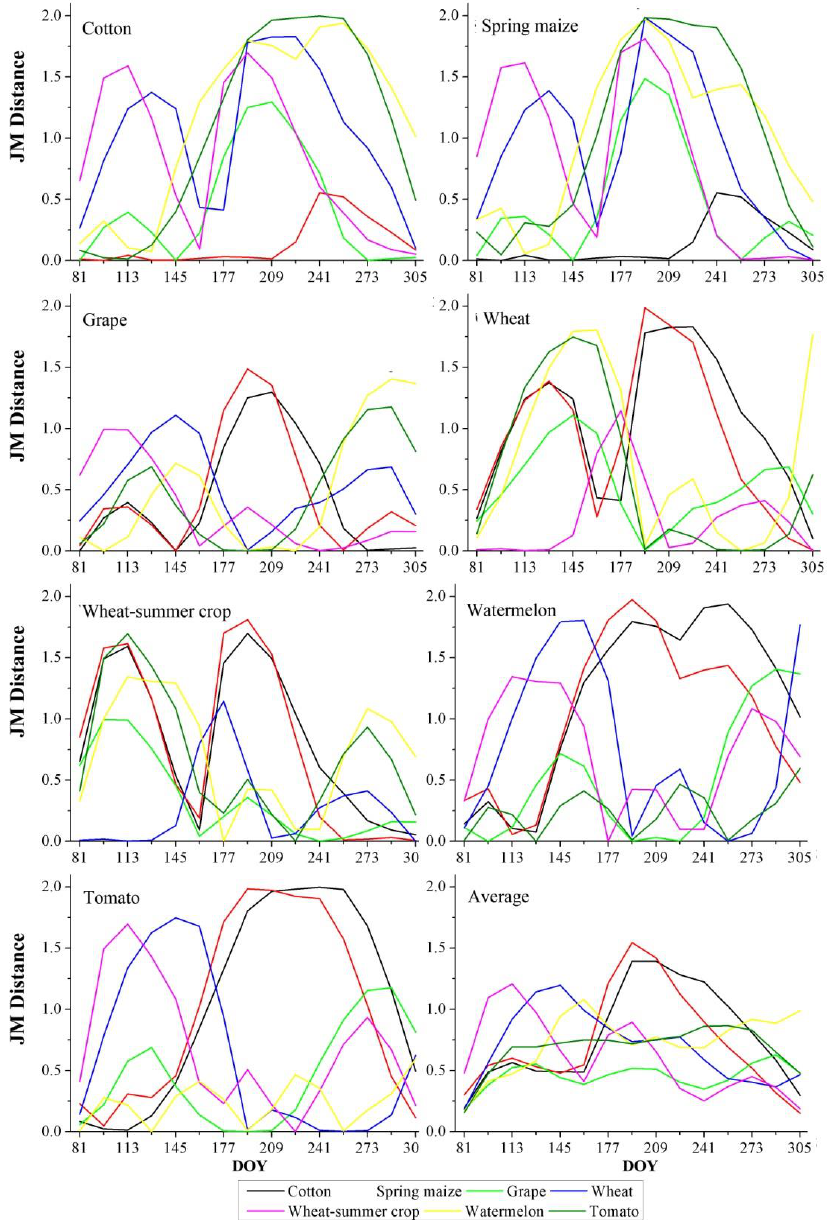
Figure 8. JM distances of all pair-wise crop comparisons for reference NDVI time series. Table 7. JM distances for all pair-wise crop comparisons during the entire time series.